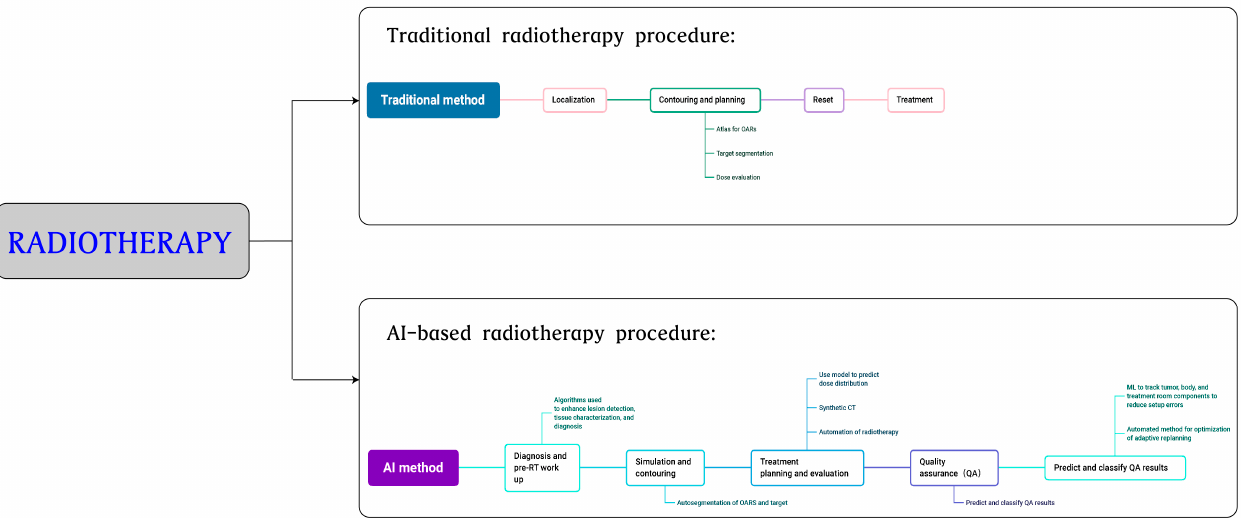
Figure 2. Comparison of radiotherapy procedures between traditional and AI-based radiation meth-